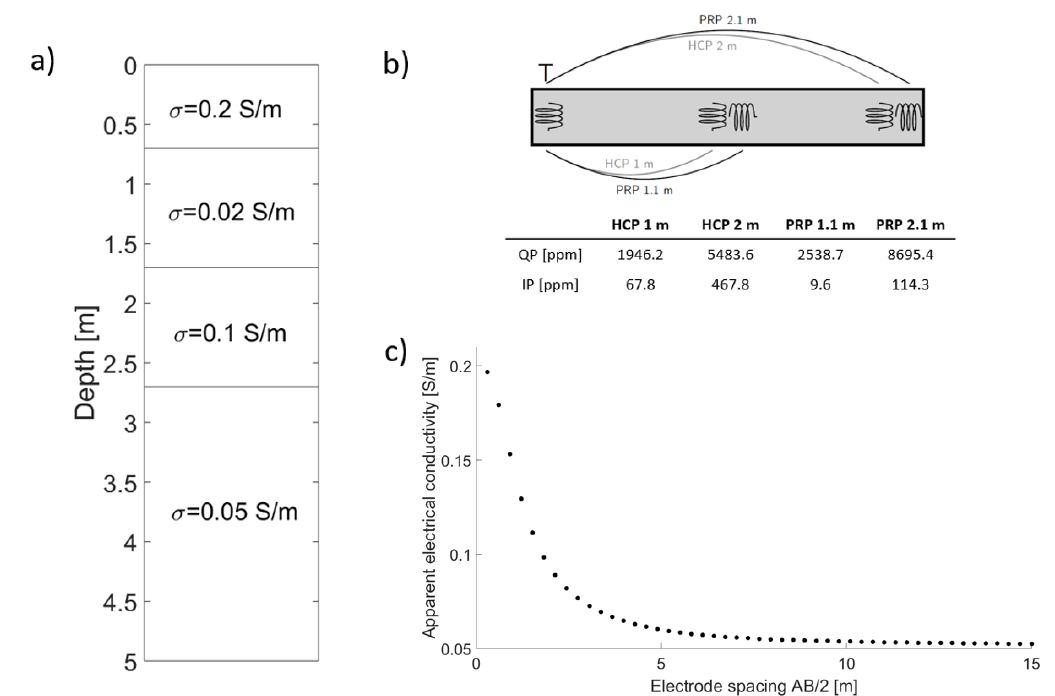
Figure 1. ( a ) Synthetic true model consisting of four subsurface layers with the lowermost layer extending to infinite depth; and, corresponding simulated data for the synthetic subsurface model ( b ) simulated in-phase (IP) and quadrature (QP) response a for frequency-domain electromagnetic device in the setups, as shown, and ( c ) apparent electrical conductivity simulated for a vertical electrical sounding setup with current electrode spacing AB and a voltage electrode spacing both of 30